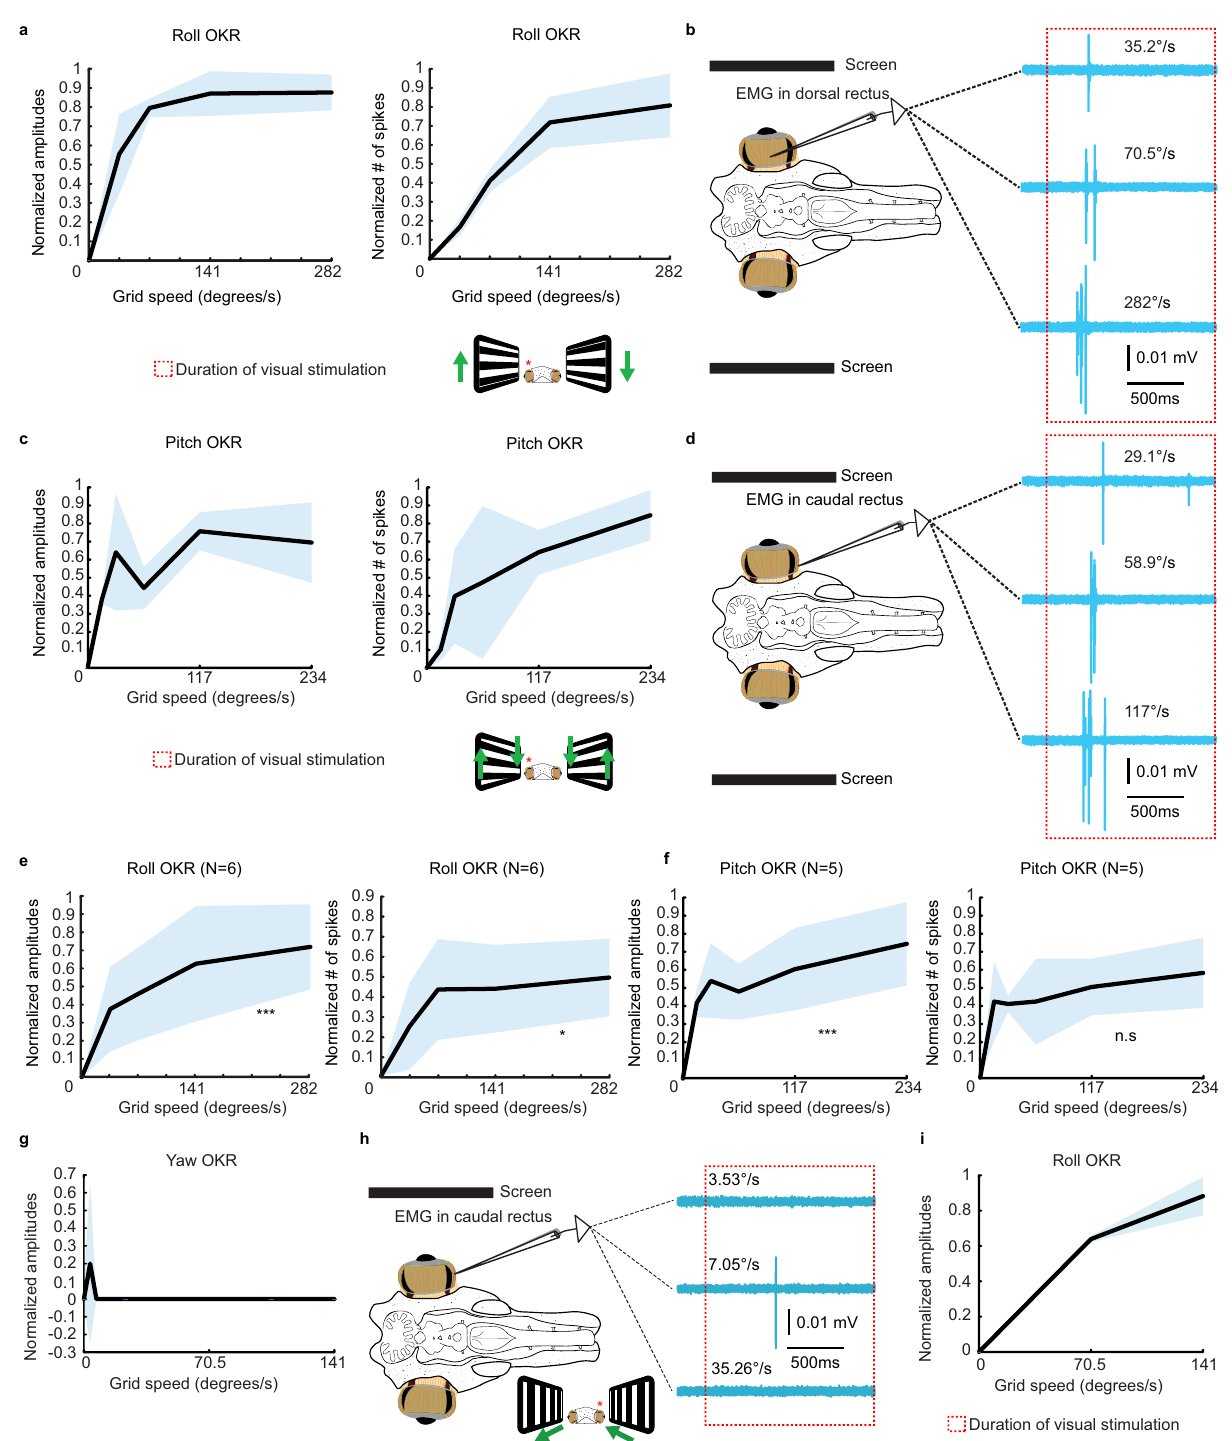
Fig.2|Lampreyoptokineticresponses.a Graphicalillustrationofthenormalized EMG amplitudes (left) and number of spikes (right) of the evoked EMG activity in the dorsal rectus of one animal during optokinetic stimulations in the roll plane across a range of velocities. b Representative traces at three different velocities during roll stimulations. The dotted rectangle indicates the duration of the opto- kinetic stimulation. c Graphs showing the EMG activity in the dorsal rectus of one animal during optokinetic stimulations in the pitch plane across a range of velo- cities. d Representative traces at three different velocities during pitch stimula- tions. e , f MeanEMGamplitudesandspikesre fl ectingtheEMGactivityinthedorsal rectus in response to optokinetic stimulation in the roll ( e ) and pitch ( f ) planes combining the data from six animals for roll, and fi ve for pitch. A repeated